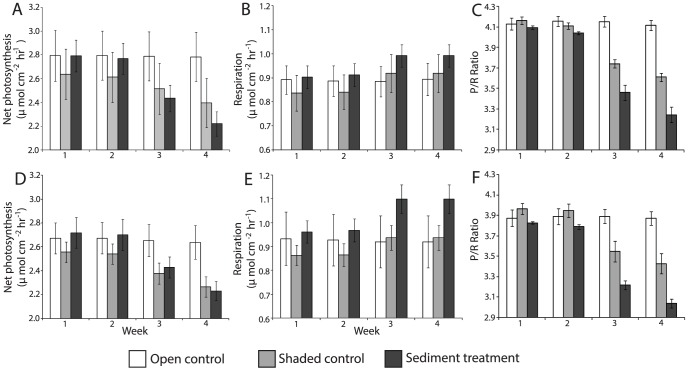
Net photosynthetic rates, the respiration rates and the P/R values for G.fascicularis (A, B, C) and G.somaliensis (D, E, F) over four weeks in the open control (white), shaded control (grey) and sediment treatment (black).The error bars represent standard errors (SE), and n = 4.